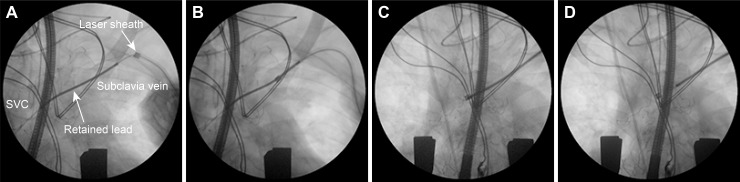
Retained lead extraction using the excimer laser in a hybrid operating room.(A) Insertion and One-Tie fixation of a locking stylet into retained lead. B-D) Excimer laser sheath advancing over the lead with laser ablation and complete extraction of retained lead.